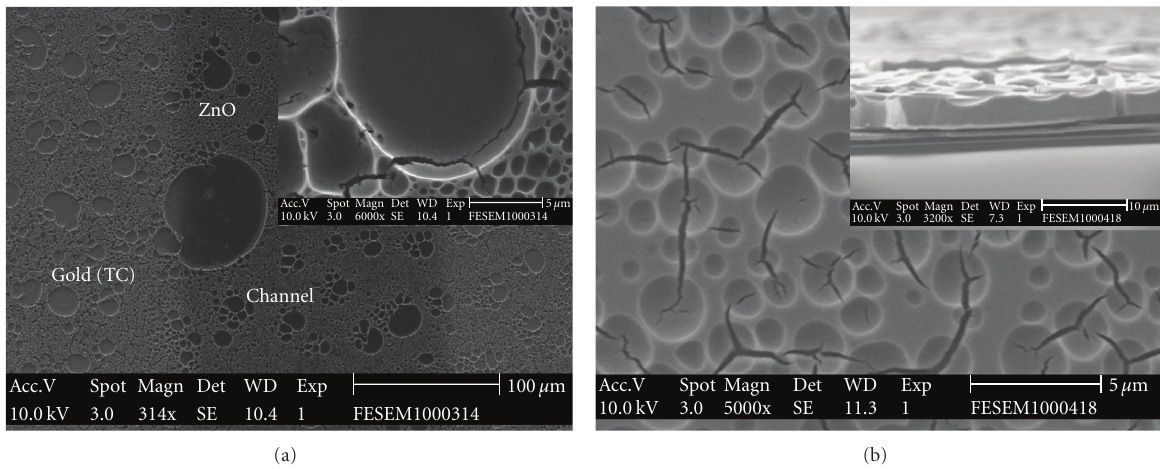
Figure 4: Scanning electron microscopy image of the inkjet-printed ZnO-NPs film using various concentrations onto the IJP-dielectric layer of a top-cntact transistor (plain view): (a) 3wt%; (b) 7wt%.